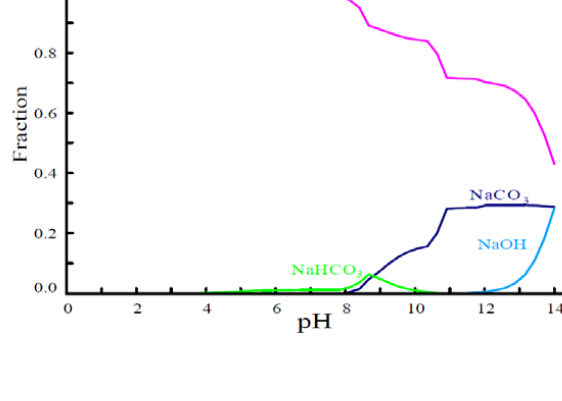
( c ) Figure A1. Effect of Na 2 CO 3 addition on K + (a), Na + (b), and Zn 2+ (c) phase equilibria in leaching solution.